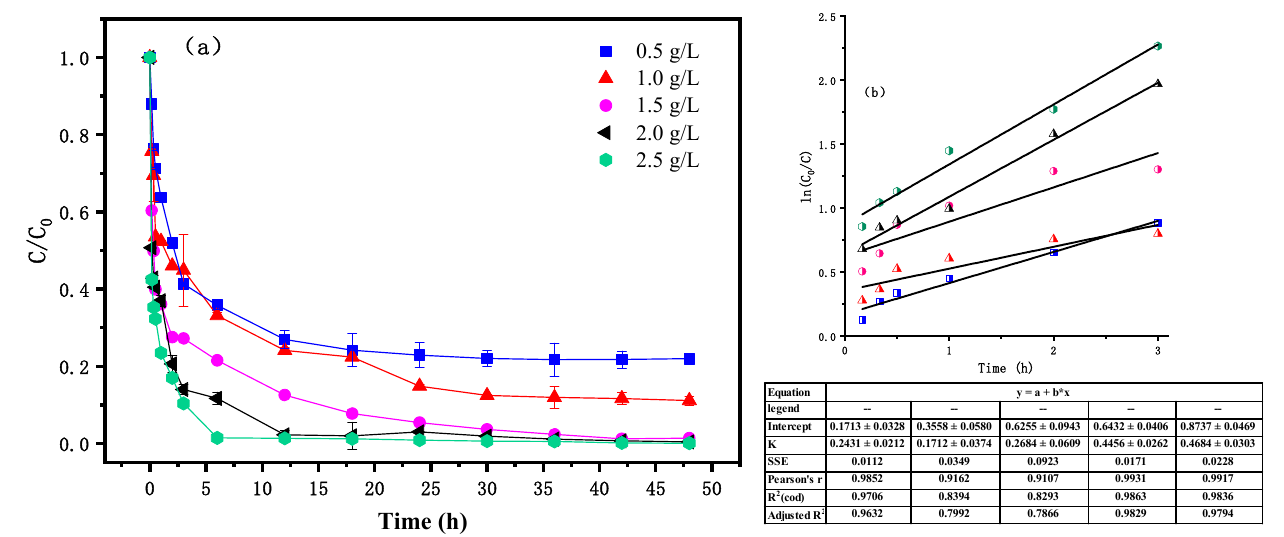
Figure 9. Effect of Co-nZVI/GAC dose on degradation curve and linear fitting. PNP degradation curves with different Co-nZVI/GAC Dosage ( a ), Dynamic fitting curve ( b ).